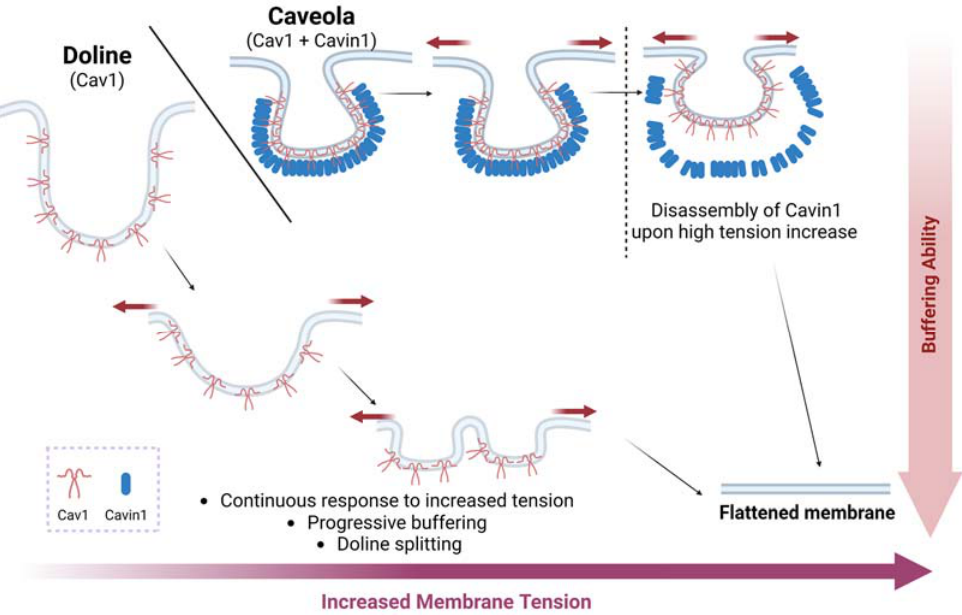
Figure 1. Cav1 can buffer PM tension via different mechanisms. Dolines (bigger and irregular PM invagination devoid of PTRF) gradually buffer low–medium mechanical force increases, while caveolae (regular PM nanoinvaginations, size-restricted by PTRF binding) provide acute buffering to higher forces, only flattening beyond a certain tension threshold. Thus, dolines exhibit a ‘spring- like’ response vs. the ‘mechanical switch’ constituted by caveolae. Created with BioRender.com accessed on 15 January